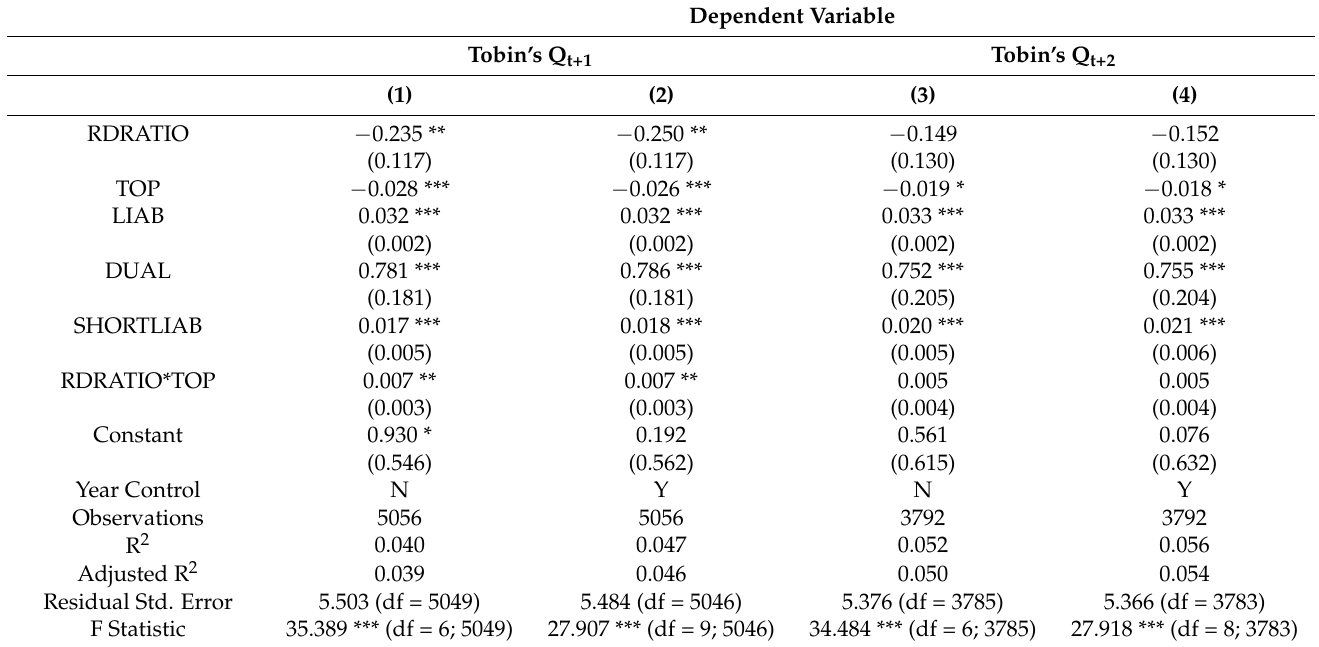
Table 5. Research expense and Tobin’s